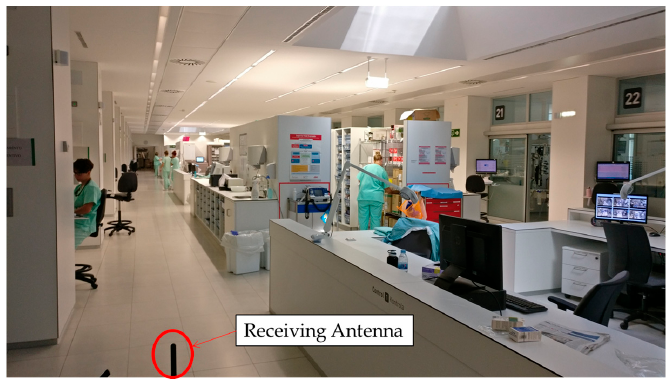
Figure 14. Picture of the UCI, taken during the measurements.